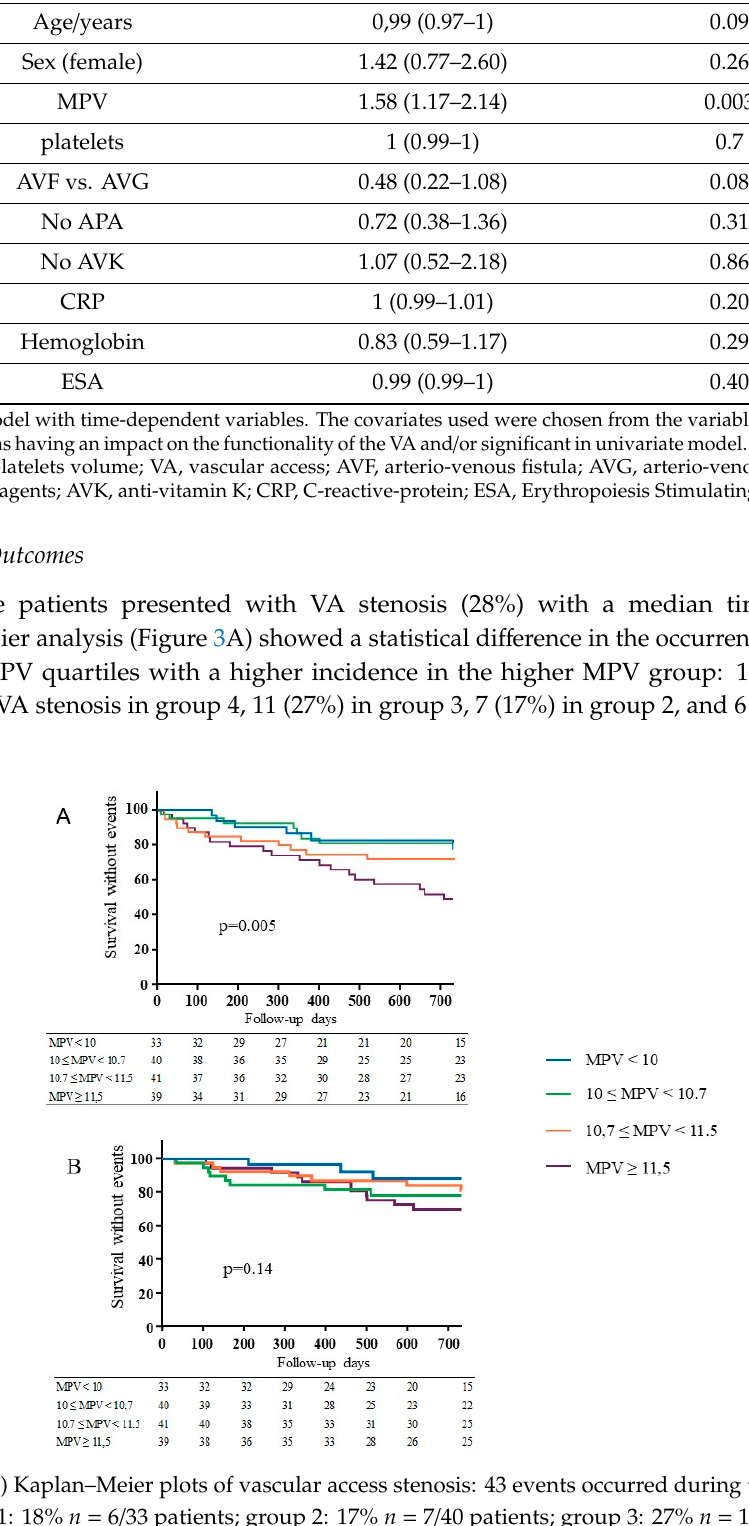
Table 4. Multivariate analysis by the Cox model of vascular access stenosis.